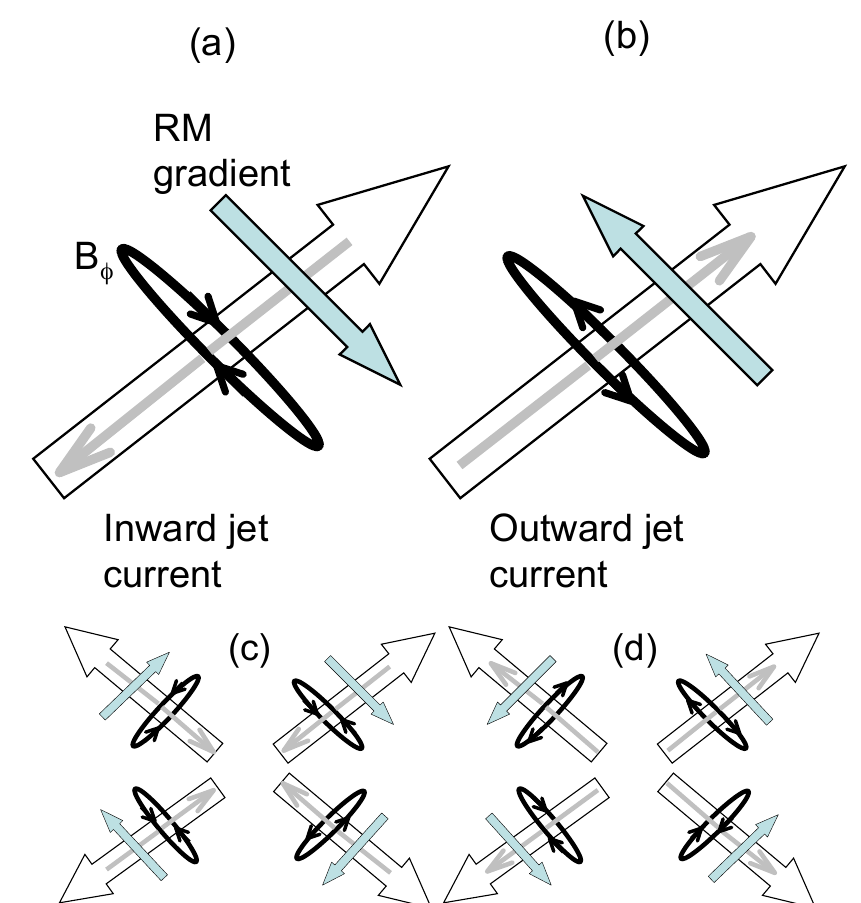
Figure 4. Relationship between the direction of a jet current, its azimuthal B field B φ , and the resulting transverse RM gradient for ( a ) inward; and ( b ) outward jet currents. In each panel, the large hollow arrow shows the jet direction, the grey arrow the direction of the jet current, the bold circle the direction of B φ , and the filled arrow crossing the jet the direction of the transverse RM gradient; ( c ) Same as panel (a) for jets in four different directions; the orientations of the transverse RM gradients form a clockwise pattern on the sky; ( d ) Same as panel (b) for jets in four different directions; the orientations of the transverse RM gradients form a counter-clockwise pattern on the